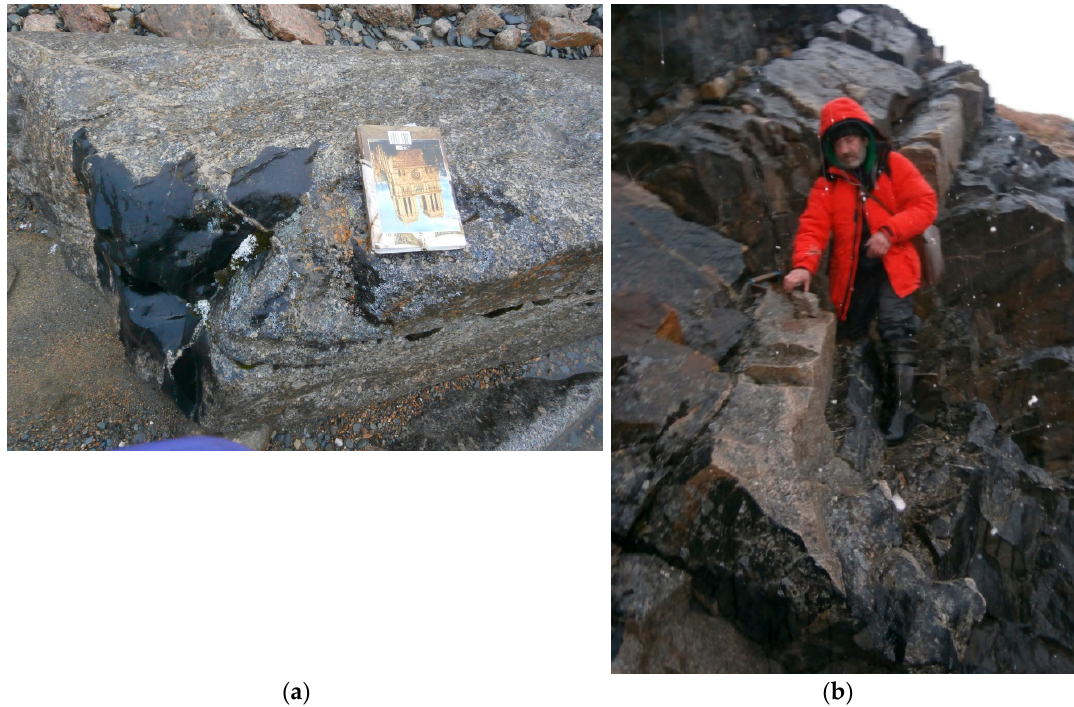
Figure 5. Field photographs of ( a ) xenoliths of amphibole-hornblende schists in granodiorites in the vicinity of Zeeberg Bay; ( b ) concordantly occurring granodiorite apophyses in hornfelsed terrigenous host rocks (Oleniy Creek, vicinity of Zeeberg Bay).